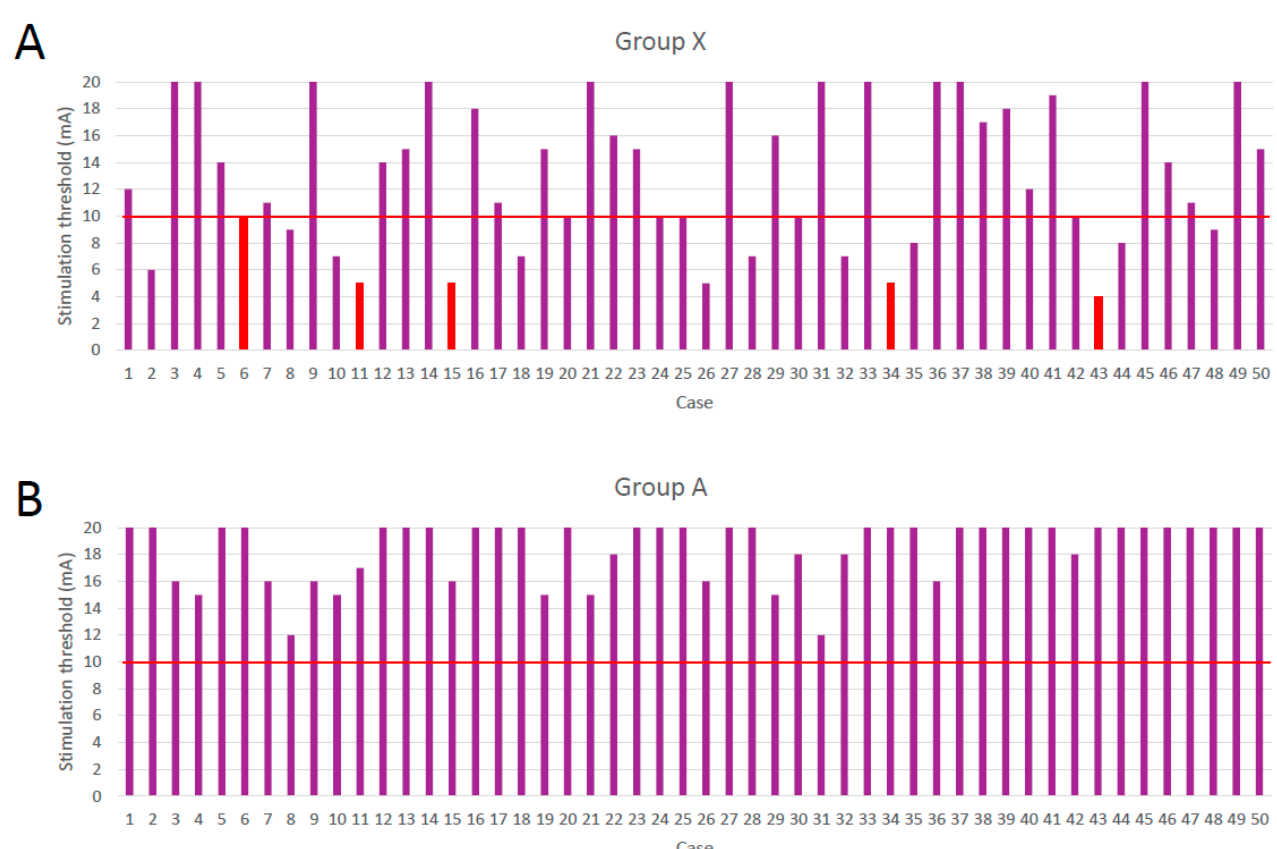
Figure 4. In ( A ) Group X and ( B ) group A, the stimulation value is measured during intraoperative neuromonitoring using the NVM5. Yellow (6–10 mA) or red ( ≤ 5 mA) signals were considered warning signals. Patients 6, 11, 15, 34, and 43 in group X experienced neurological complications.